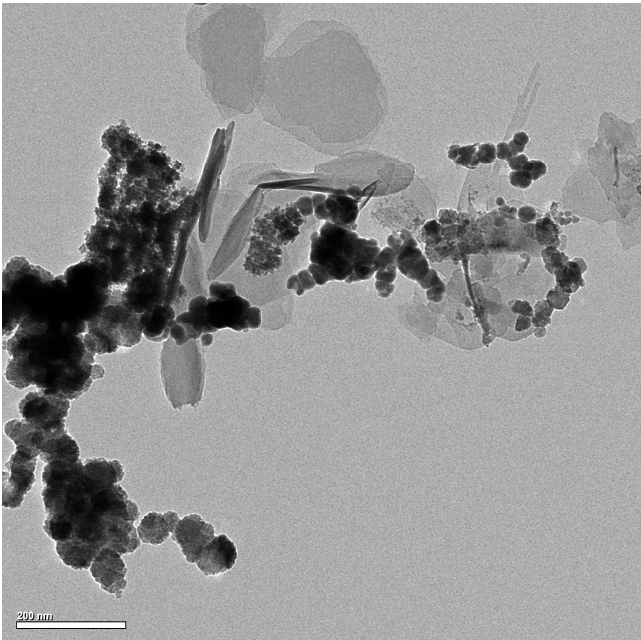
Figure 7. TEM image of bare Pd/Fe nanoparticles that have reacted with trichloroethylene for 10 h. The weight percentage of Pd to Fe is 0.30%, C TCE,0 = 23.7 mg/L (0.181 mmol/L), iron loading = 1.91 × 10 3 mg/L (34.2 mmol/L).